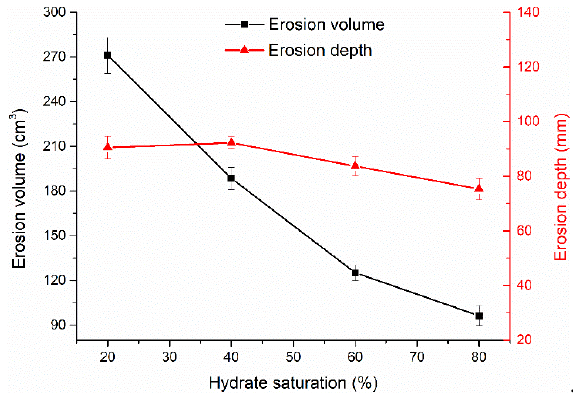
Figure 8. The influence of hydrate saturation on erosion volume and erosion depth.